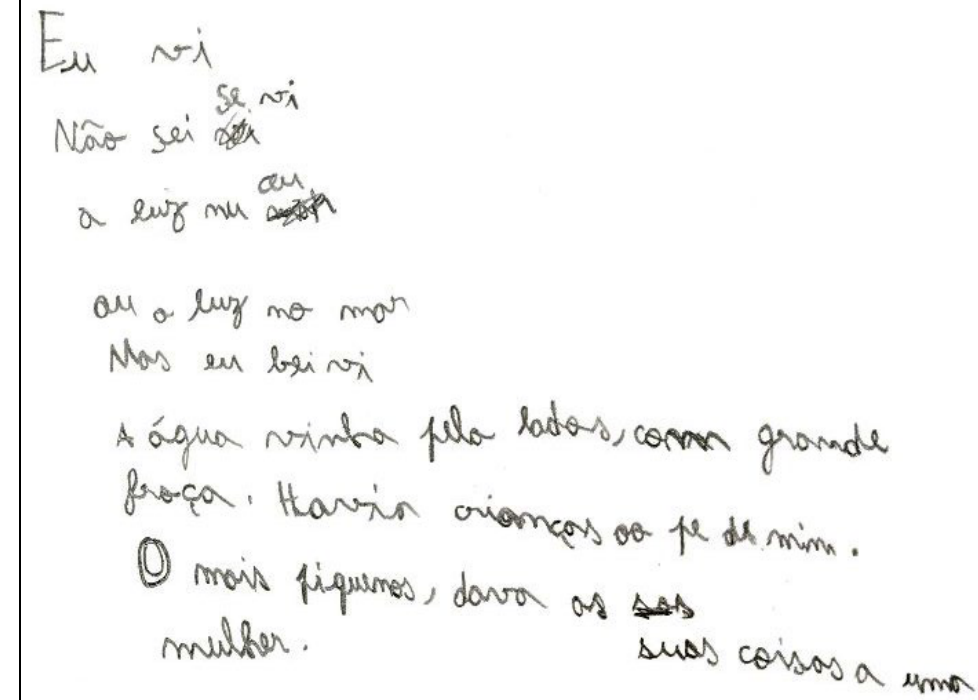
Figure 2. BHK text (Portuguese version obtained from the French version [15]—Figure A1 in Ap- pendix A). Participants copied the BHK text, composed of progressively more complex words, for 5 min.